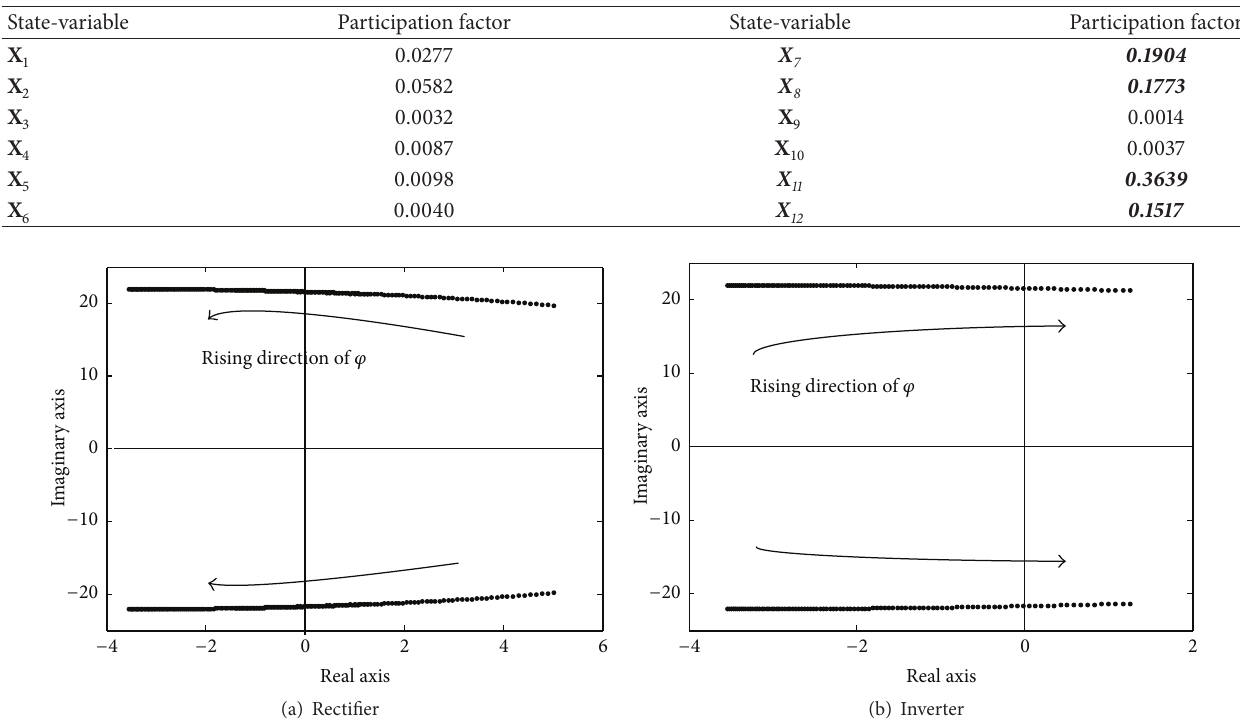
Table 4: The calculated participation factors of test model.